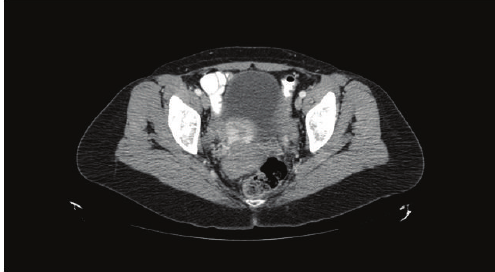
Figure 6: CT scan